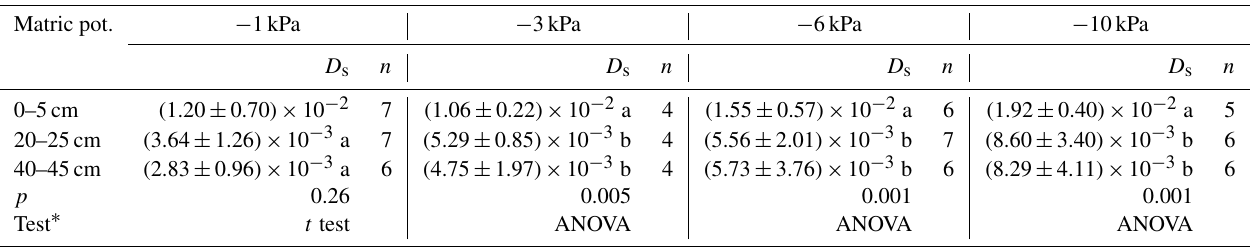
Table 2. Means and standard deviations for the measured N 2 diffusion coefficients ( D s , cm 2 s − 1 ) of the peat samples at different matric potentials.